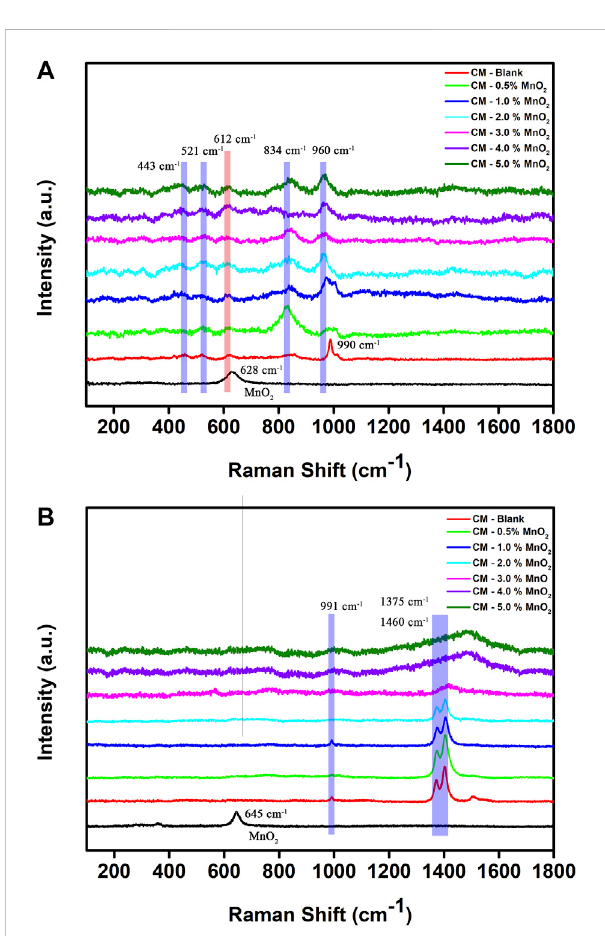
FIGURE 2 Raman spectra of Mn doped clinker samples recorded with (A) 514 nm and (B) 633 nm laser excitation (red: CM-blank, green: CM- 0.5% MnO 2 , blue: CM-1% MnO 2 , cyan: CM-2% MnO 2 , magenta: CM- 3% MnO 2 , violet: CM-4% MnO 2 , olive: CM-5% MnO 2 , black: MnO 2